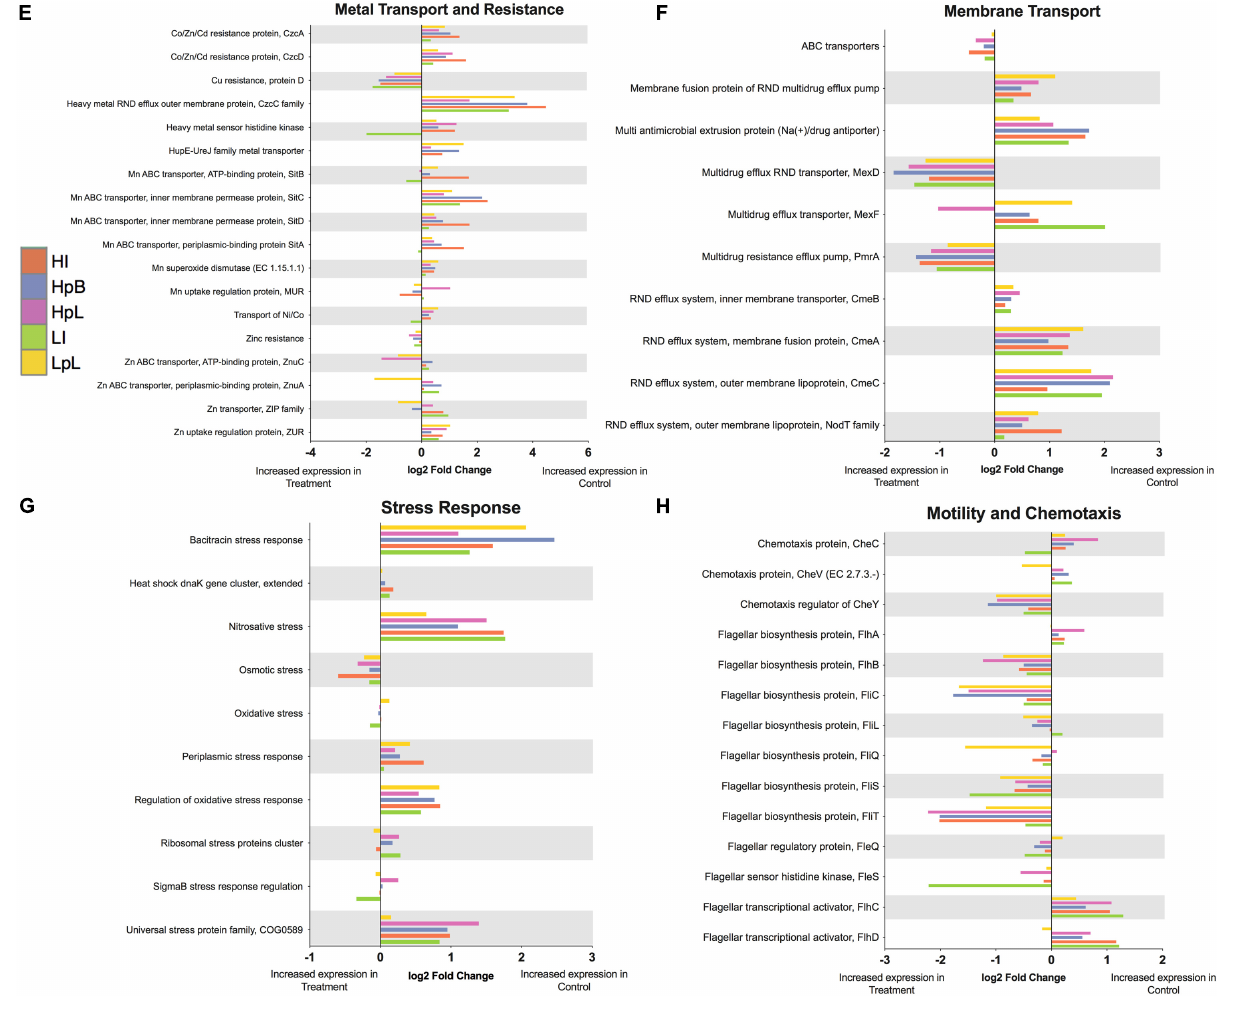
high ionic Zn treatments, relative to controls ( Figure 5B